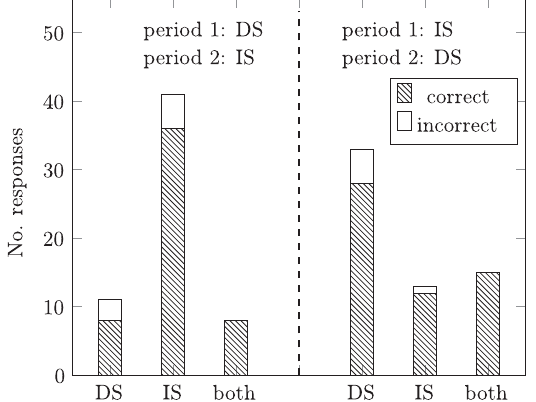
FIG. 9. Number of correct and incorrect responses per strategy summarized for vector field plots V6 – V8. The left part of the figure refers to those students which were first instructed by the differential strategy and then by the integral strategy, and the right part refers to the reverse order; cf. Fig.